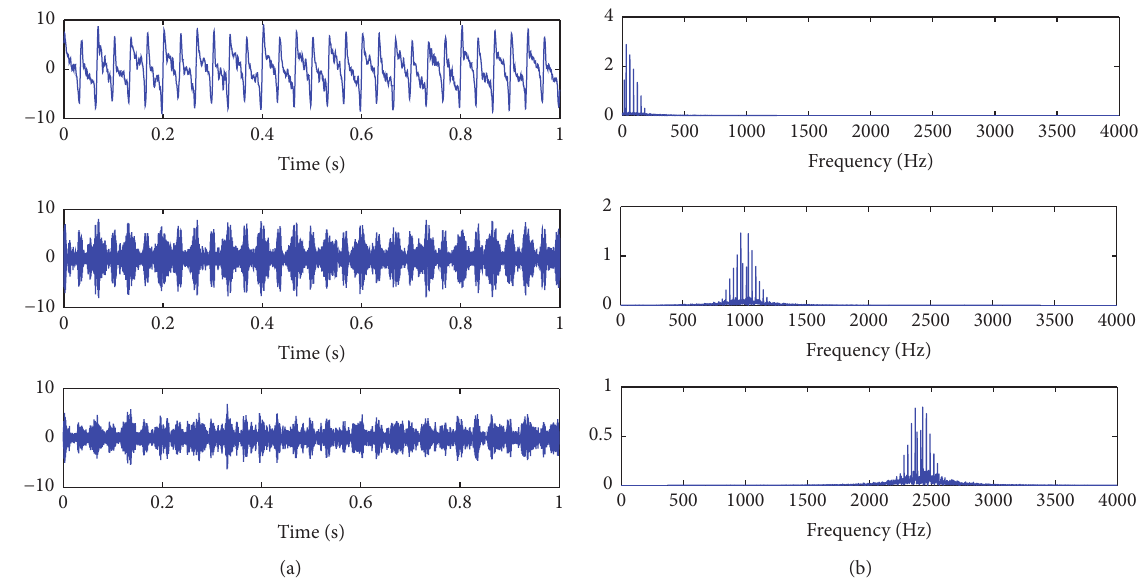
Figure 2: VMD subsignals (a) and their frequency spectrums (b) of the simulation signal.